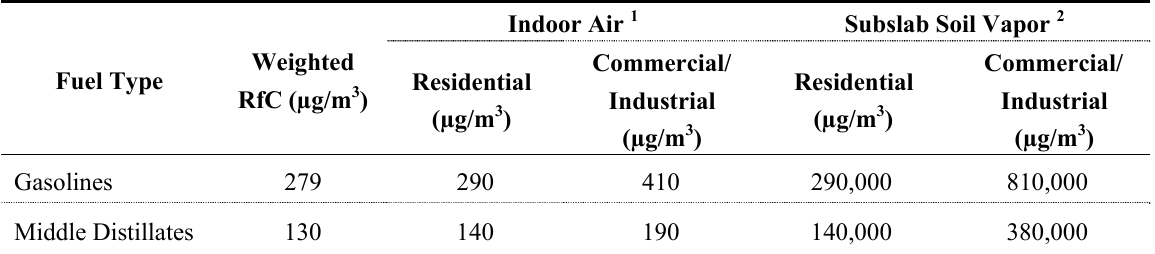
Table 7. Example, indoor air and soil vapor screening levels for TPH based on default, carbon range compositions for gasolines and middle distillates noted in